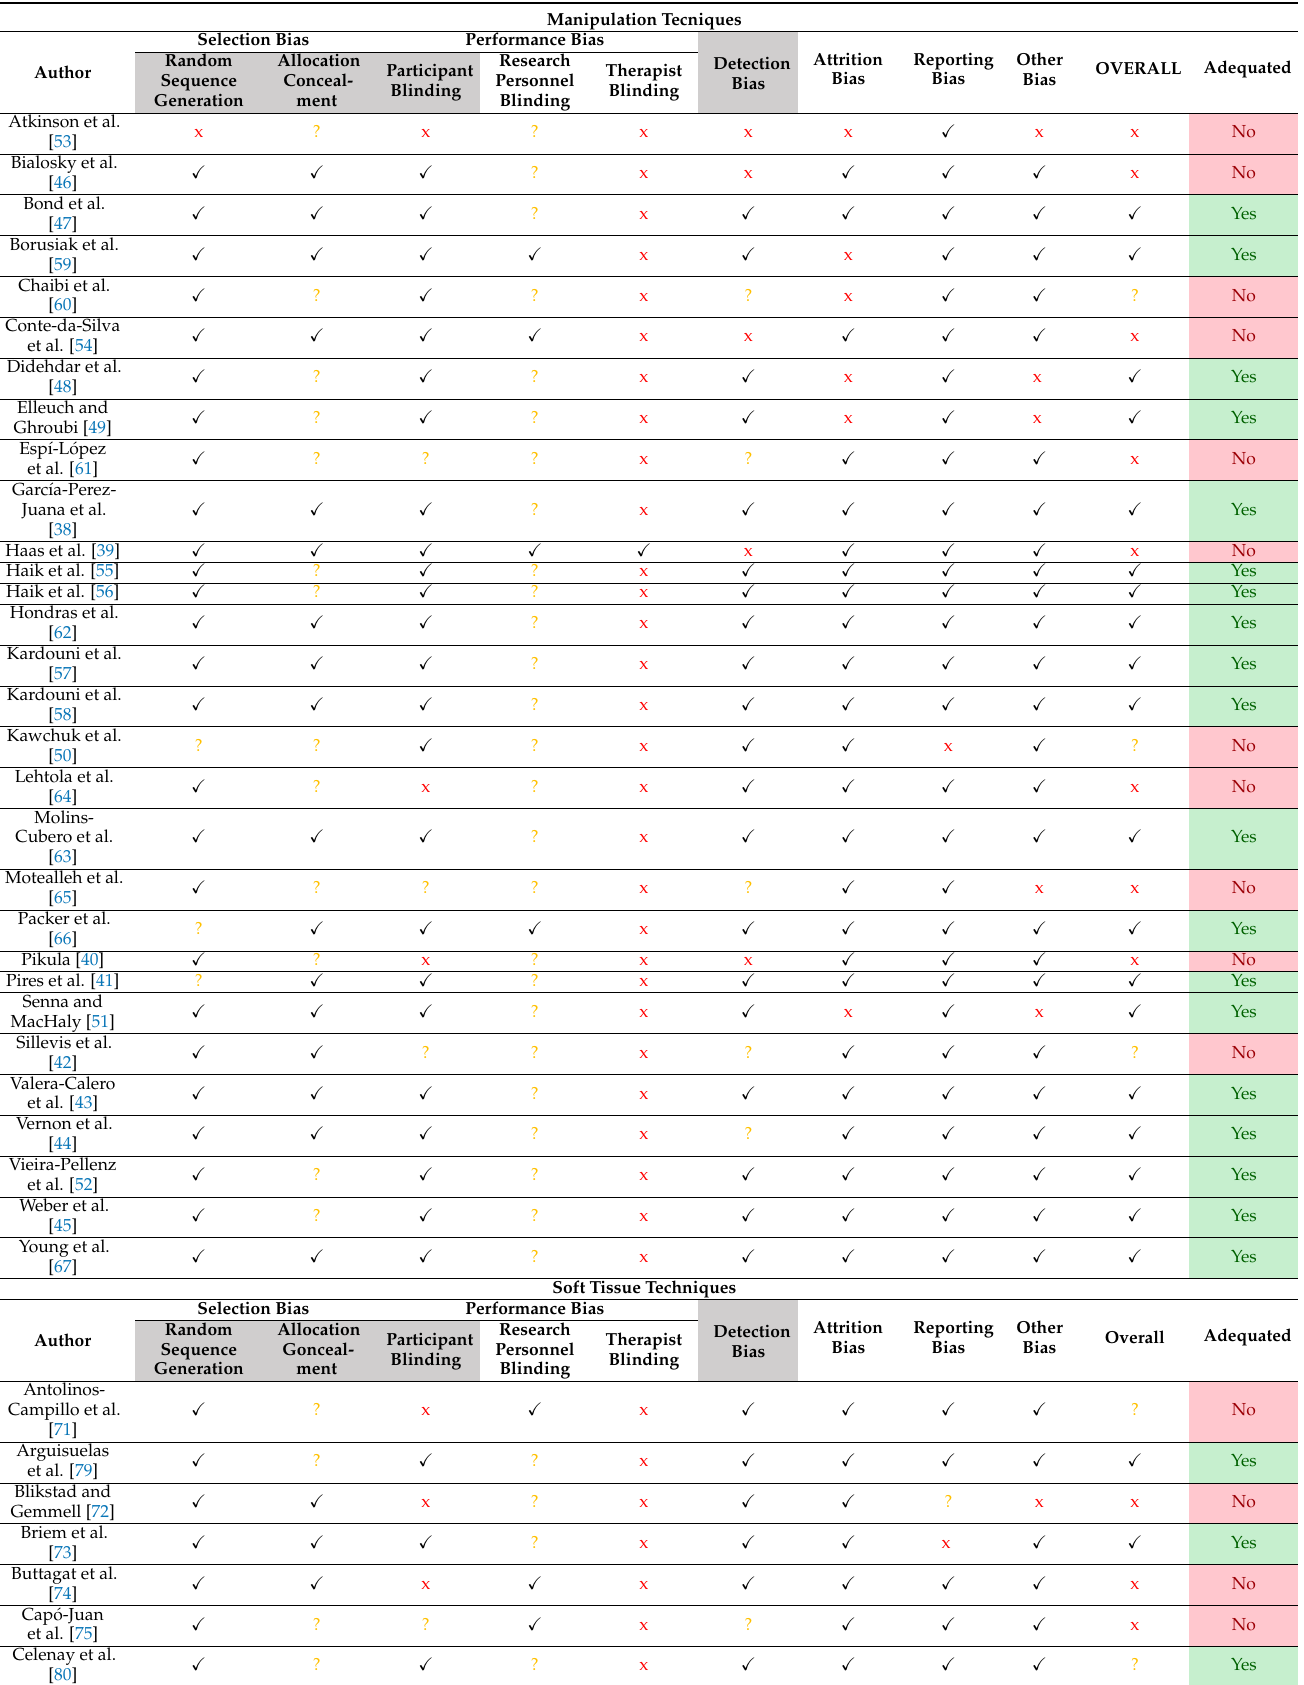
Table 2. Cochrane Risk of Bias tool for randomized trials. Risk of bias assessment (n = 53